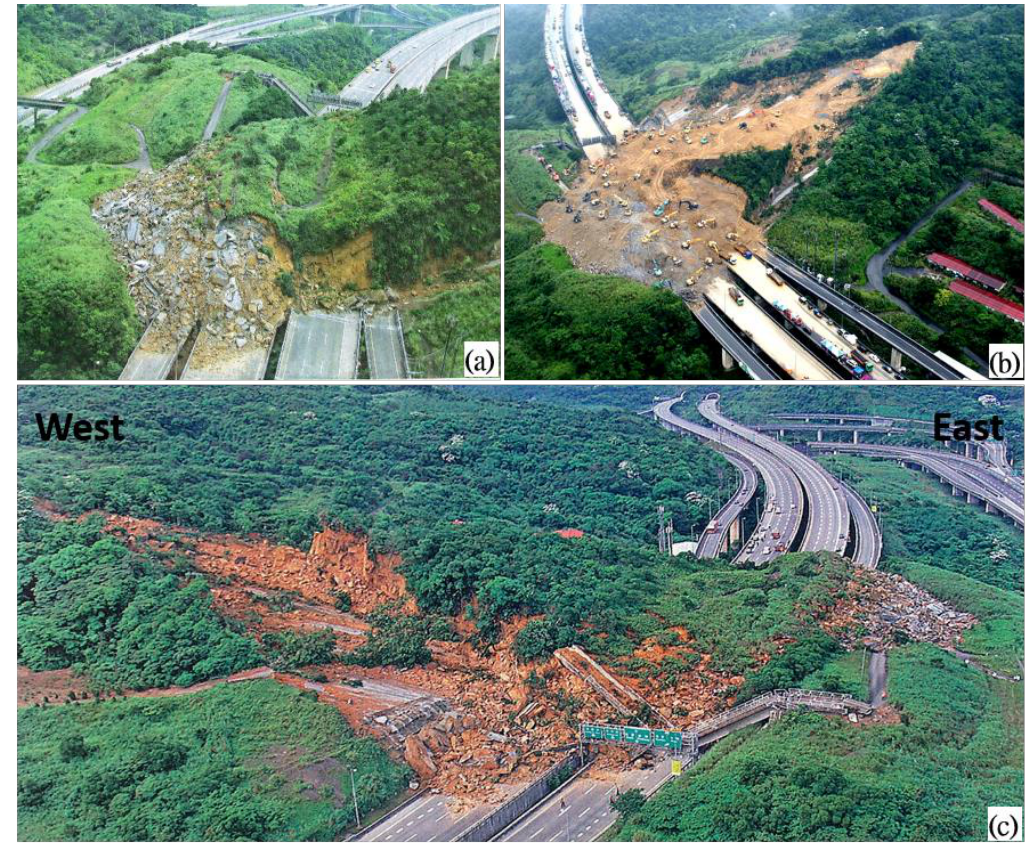
Figure 3. Aerial photos taken from site after landslide. ( a ) Photo from northeast direction; ( b ) Failure plane during the removal of debris; ( c ) Photo from south direction.